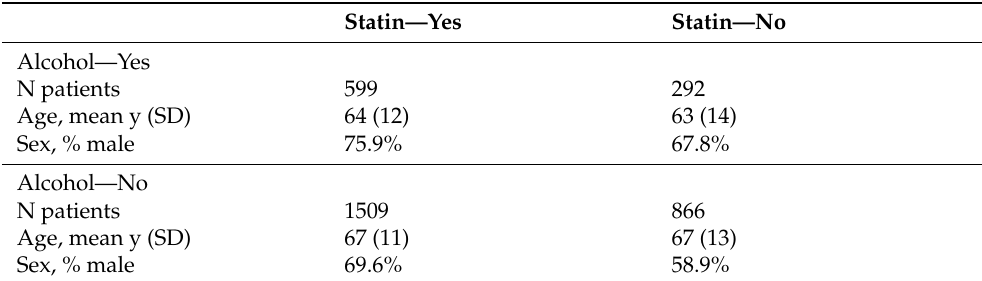
Table 2. Frequencies by Alcohol and Statin Category, together with Age and Sex in Patients at Secondary Cardiovascular